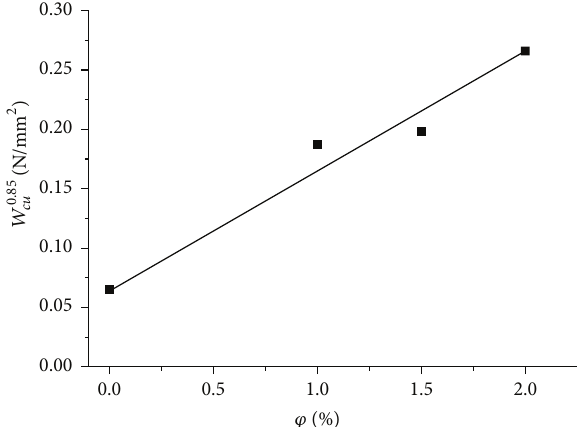
Figure 6: Relationship between equivalent compressive toughness index and volume ratio of PVA